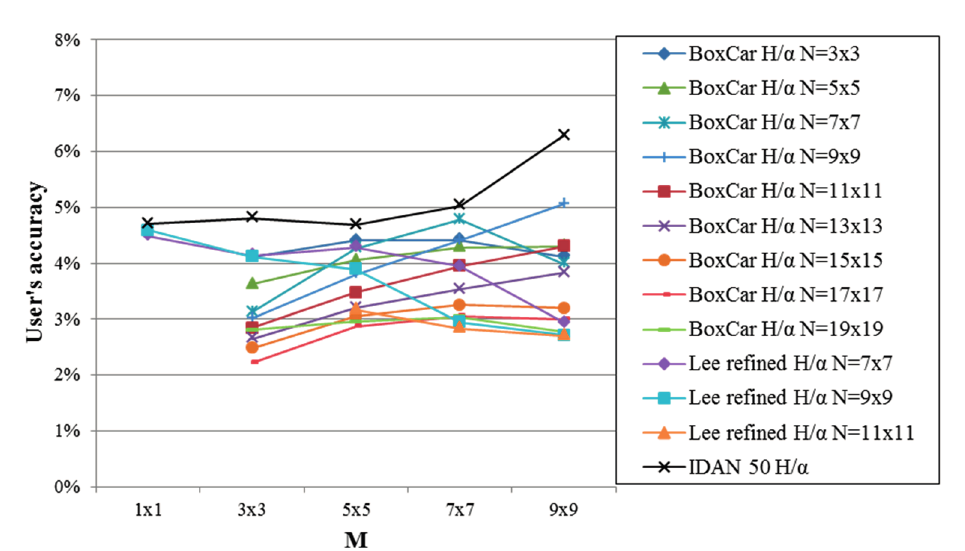
Figure 6. User’s accuracy vs. window size M after the pixel-based PolSAR classification based on H/ α (box car, refined Lee and IDAN filter) for the first TerraSAR-X acquisition (5 September